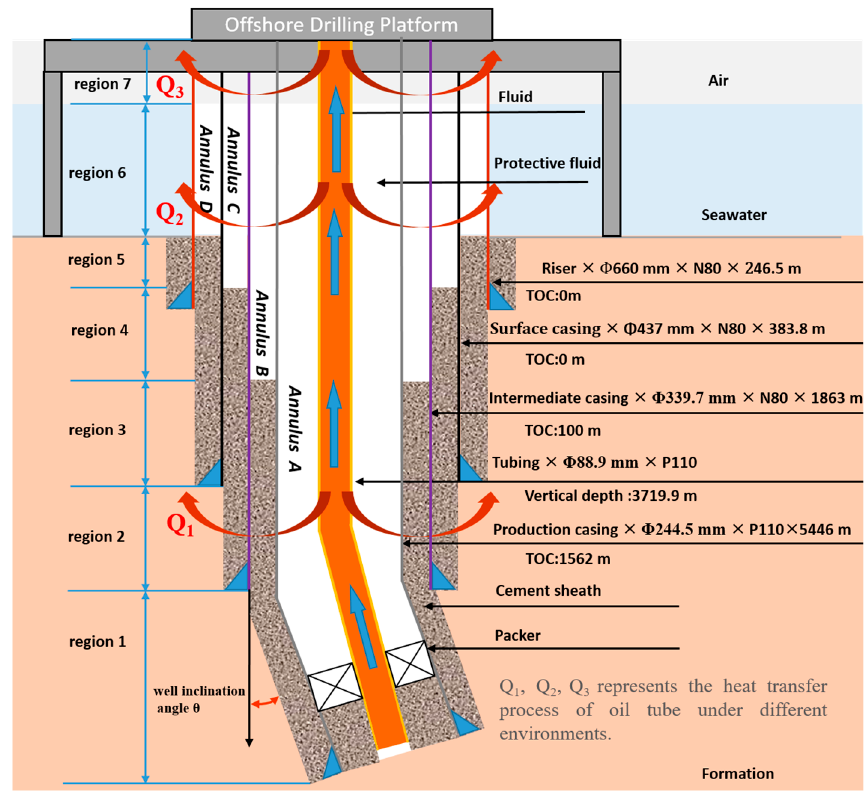
Figure 1. Schematic of wellbore